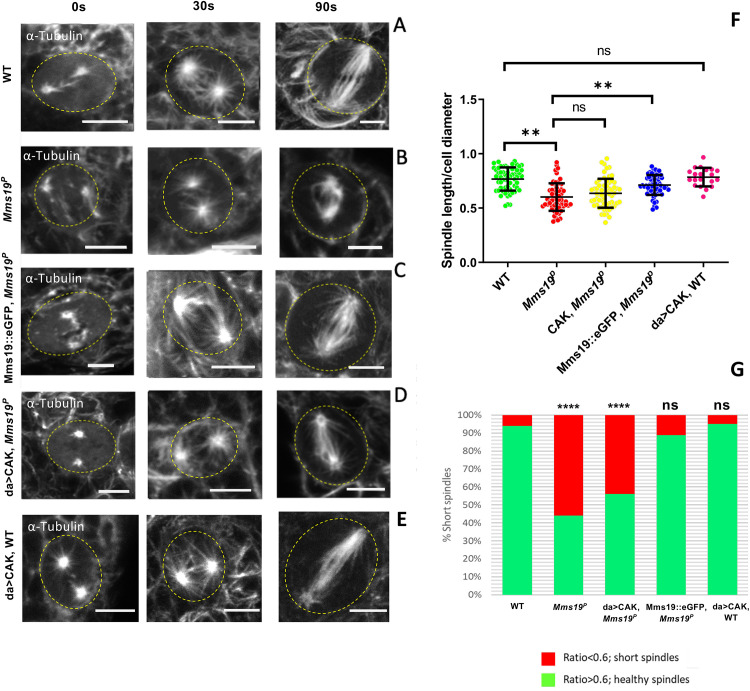
Mms19 is required for spindle re-assembly.After cold treatment, spindle re-assembly was analyzed at 0 sec (i.e. immediately after cold treatment; left panel), 30 sec (central panel), and 90 sec (right panel) after shifting them to 25°C. For this, the tissue was fixed and immunostained for α-tubulin. At 0 sec in the WT NBs (A), only centrosomes were visible, but after incubation at 30 sec, few fibers had nucleated from the centrosomes and around the chromatin. At 90 sec, the spindle regained its normal shape and density. In Mms19P NBs (B), spindles did not regain the normal shape after 90 sec. Additionally, the microtubule density was reduced in these stunted spindles. Expression of Mms19::eGFP in the mutant background (C), rescued spindle reformation, but overexpression of CAK (D) rescued only slightly and the length and density of MT still appeared reduced (B,D,F: P>0.99). (E) Overexpression of CAK in the WT background did not affect spindle re-growth. (F) The scatter plot shows the spindle length relative to the cell diameter after 90 sec incubation at 25°C. The normalization eliminates variations due to varying cell sizes. SS was calculated by Kruskal-Wallis test, columns were compared by Dunn’s post test (***P<0.001), (**P<0.01). (G) The graph compares the percentage of ‘short spindles’ across different genotypes. SS was calculated using Fisher’s exact test (****P<0.001). Scale = 5μm. WT; Mms19P; da>CAK, Mms19P; Mms19::eGFP, Mms19P: n = 60 NBs, 3 experiments. da>CAK, WT: n = 20, 2 experiments.